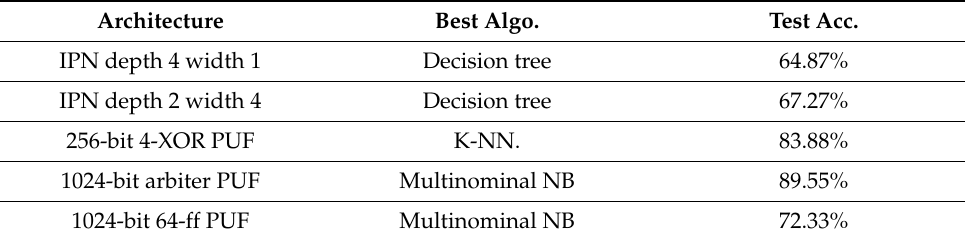
Table 3. Auto-sklearn modeling results on raw